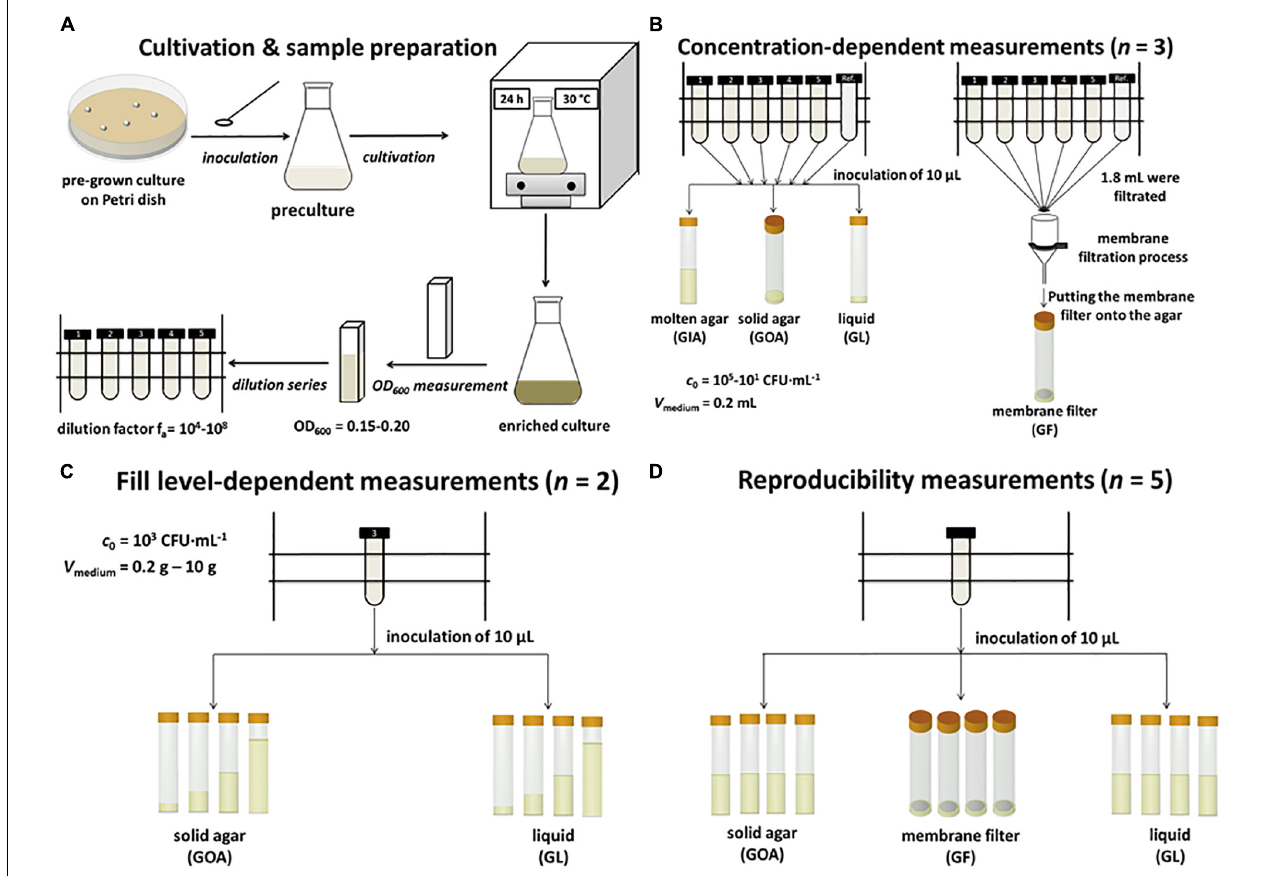
FIGURE 1 | Schematic summary of the methodology. (A) Cultivation and sample preparation. (B) Concentration-dependent measurements of GIA, GOA, GL, and GF. (C) Fill level-dependent measurements of GOA and GL. (D) Reproducibility of measurements of GOA, GL, and GF.